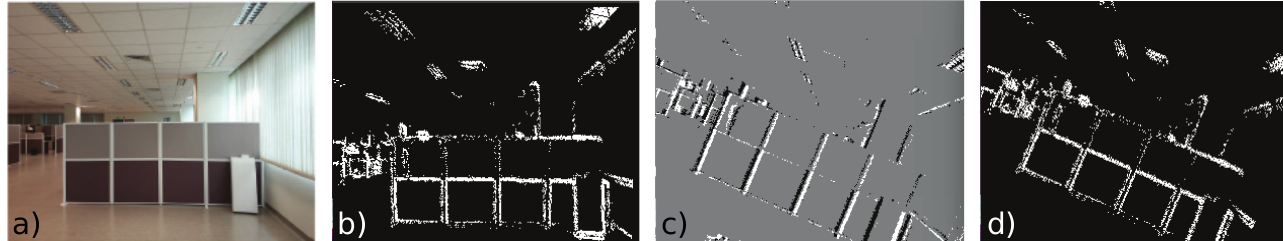
Figure 2. Example of point cloud initialization and LUT computation. ( a ) A photo of the scene captured by a cell phone camera (here only for illustration and not used in the processing). ( b ) Frame showing the accumulated events used to generate the point cloud at initialization. The 3D points are the projection of the events onto a plane at a distance provided by the user. ( c ) A frame of events captured during a sensor rotation. ( d ) The same 3D points initialized in ( b ), projected into the LUT for a later sensor pose corresponding to ( c